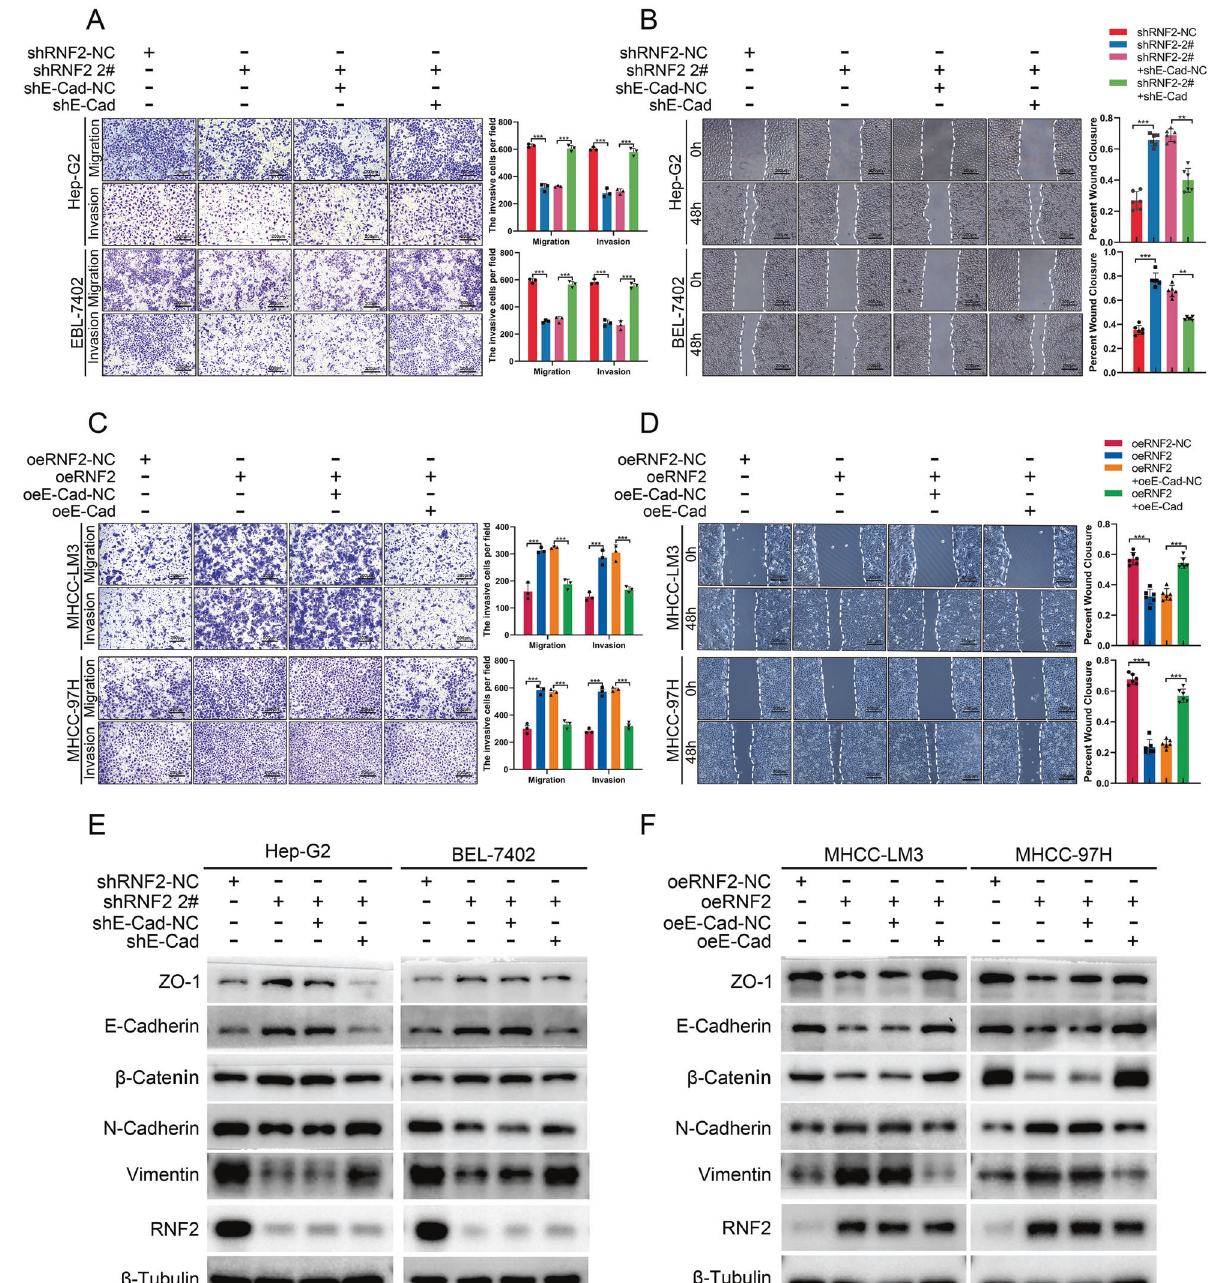
Fig. 5 E-Cadherin was involved in RNF2-mediated EMT in HCC cells. A , B Representative images and quantitative analysis of Tanswell assay and Wound healing assay using transfected Hep-G2/BEL-7402 cells. C , D Representative images and quantitative analysis of Tanswell assay and Wound healing assay using transfected MHCC-LM3/MHCC-97H cells. E Western blot results of altered EMT-related protein expression after knockdown of RNF2 in Hep-G2/BEL-7402 cells and reversal of this alteration by co-knockdown of E-Cadherin. F Western blot results of altered EMT-related protein expression after overexpression of RNF2 in MHCC-LM3/MHCC-97H cells and reversal of this alteration by co- overexpression of E-Cadherin. and ubiquitin-proteasome pathway, which in turn affect the RNF2 in HCC, which revealed a novel biomarker for HCC diagnosis. metastatic ability of HCC cells. [32, 40 – 43] Here, we demon- Meanwhile, RNF2 was identi fi ed as an oncogene that could be a strated that aberrant expression of RNF2 affected the expression potential target for HCC treatment. of EMT-related proteins, which inhibited the expression of EMT is a critical process for cancer metastasis, and its onset epithelial markers and but promoted that of mesenchymal requires the cooperation of multiple molecular factors. [17, 18] markers (Fig. 3E). [43]. Previous studies have shown that in HCC, the expression of EMT- E-Cadherin, an important member of epithelium-associated related gene is regulated through transcriptional regulation, molecules whose expression is regulated by multiple pathways RNA methylation modi fi cation, DNA methylation modi fi cation, Cell Death and Disease (2023)